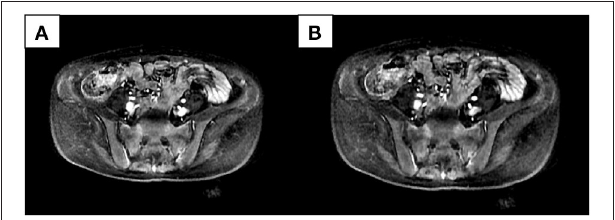
FIGURE 1 | Female, 28 years old, chief complaint of lumbago for 21 months, exacerbation accompanied by generalized asthenia for 6 months. Erythrocyte sedimentation rate, C-reactive protein, and human leukocyte antigen-B27 were all negative. Alkaline phosphatase was 269.6 U/L; inorganic phosphorus was 0.43 mmol/L. Bilateral sacral bone marrow edema signals could be seen in two continuous layers (A,B) in the short-tau inversion recovery sequence.